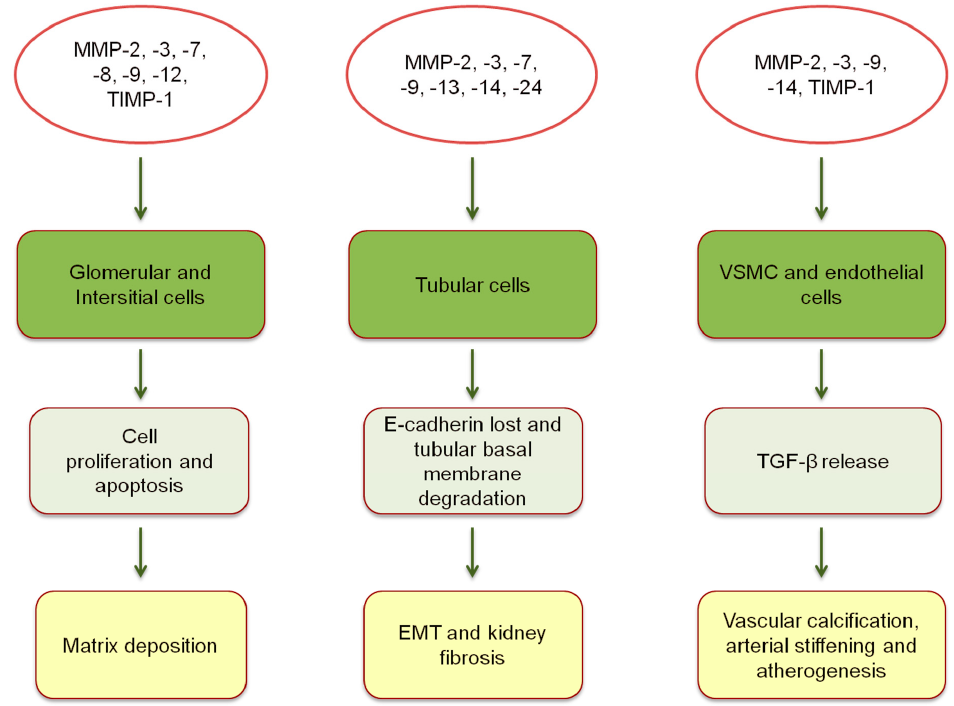
Figure 1. Expression of MMPs and TIMPs, and pathophysiological mechanisms of vascular and kidney damage [10,11,27–31]. EMT, epithelial-mesenchymal transition; VSMC, vascular smooth muscle cells; TGF- β , transforming growth factor- β